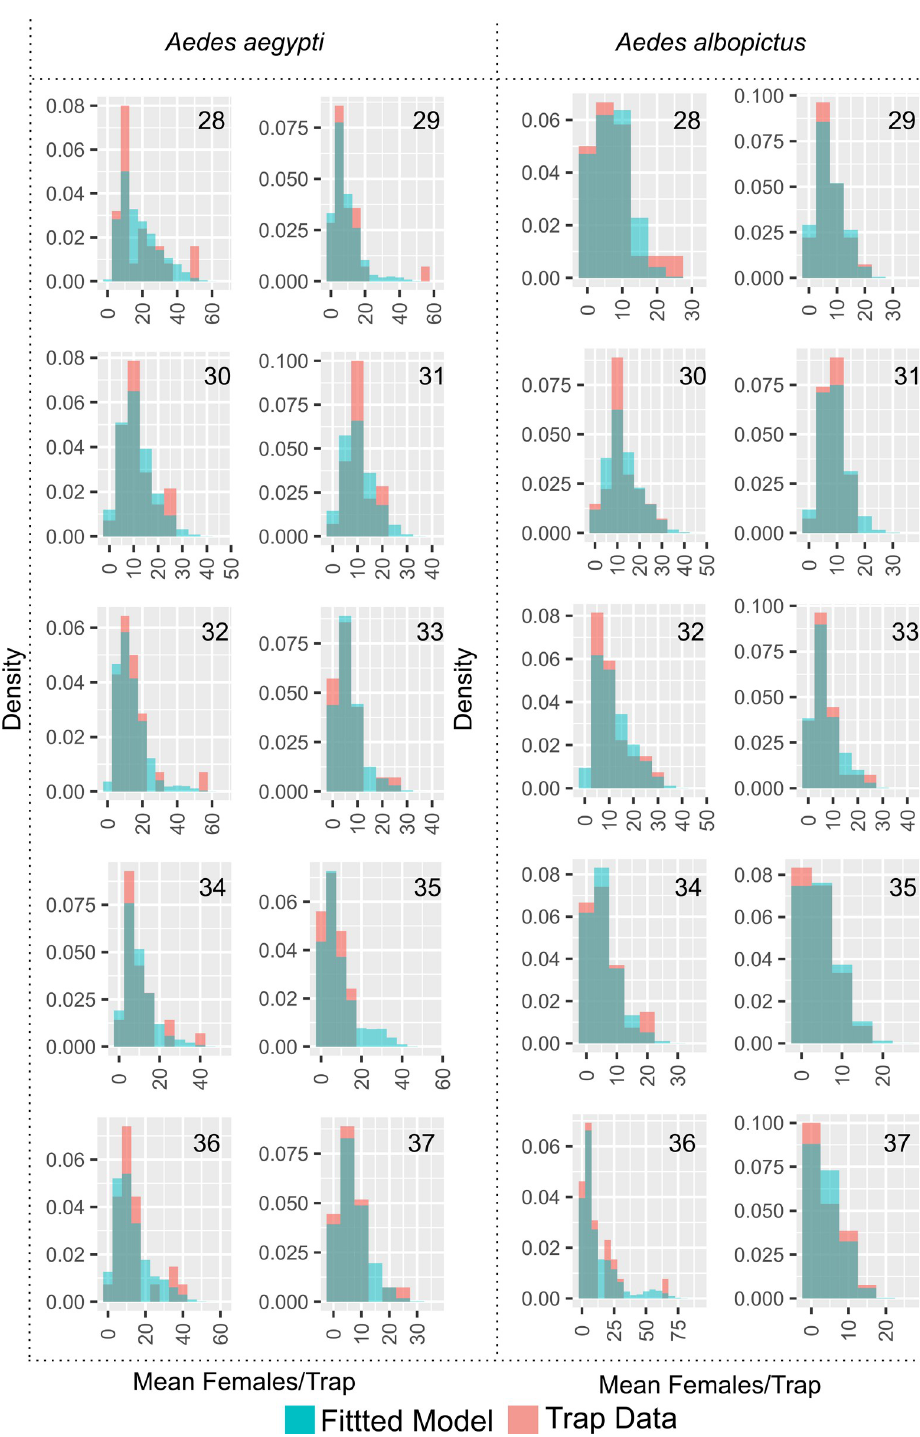
Fig 3. N-mixture fitted models for Ae . aegypti and Ae . albopictus from the untreated area by week. Blue histograms are the best N-Mixture fitted models; Red histograms are the raw trapping data (bin width = 5); the number represent the sampling week. A properly fitted model will cover most of the trapping data histogram. For example, in week 28 the model underestimated the number of traps in the 10–14 and 40–44 Ae . aegypti category (the red bars are larger than the blue